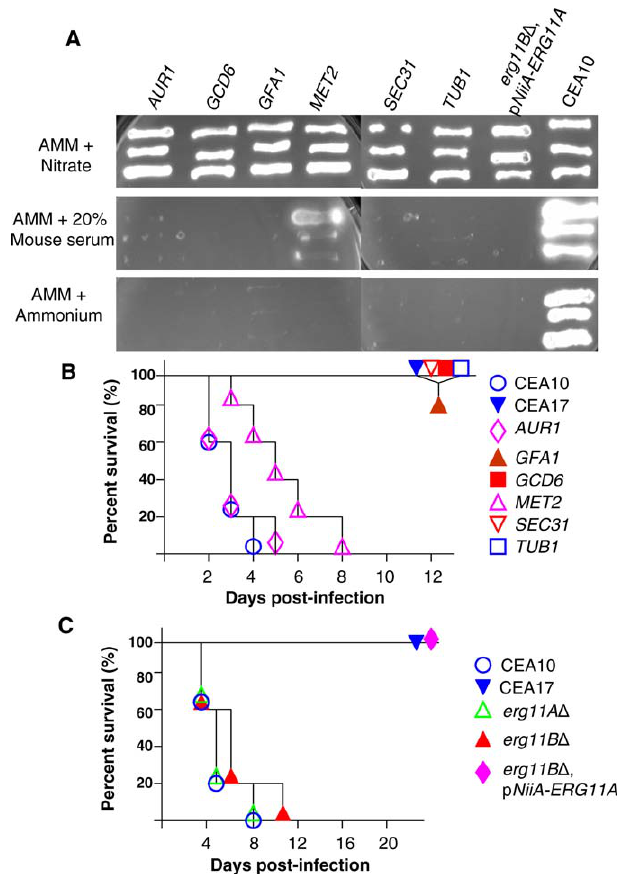
Figure 7. In Vivo Validation of A. fumigatus p NiiA -CPR Mutants in an Immunocompromised Murine Model of Systemic Infection (A) p NiiA -CPR mutants growing on AMM plus 20% mouse serum (Sigma) reproduced their terminal growth phenotypes as observed on either AMM plus ammonium or rich medium (Table 2). (B and C) In vivo validation of p NiiA -CPR mutants. (B) ICR male mice were immunocompromised by administration of cyclophosphamide at 150 mg/kg twice prior to infection and 100 mg/kg twice a week after infection. Approximately 10 5 viable conidia from individual p NiiA -CPR mutants (TUB1, SEC31, GCD6, GFA1, MET2, and AUR1) were injected into the tail vein of immunocompromised mice (five mice per group). Signs of infection were monitored for up to 12 d following infection. Wild-type strain CEA10 and the starting strain CEA17 (a pyrG (cid:2) auxotroph of CEA10) [25,39] were included as positive controls for virulence and avirulence, respectively. (C) Genetic inactivation of the ERG11 gene family promotes avirulence in an immunocompromised murine model of systemic infection. Patho- genesis of erg11A D , erg11B D , and an ERG11 double mutant (erg11B D , p NiiA-ERG11A) was similarly analyzed (as described above) but over a longer postinfection period (22 d), and animal survival was compared to CEA10 and CEA17 control